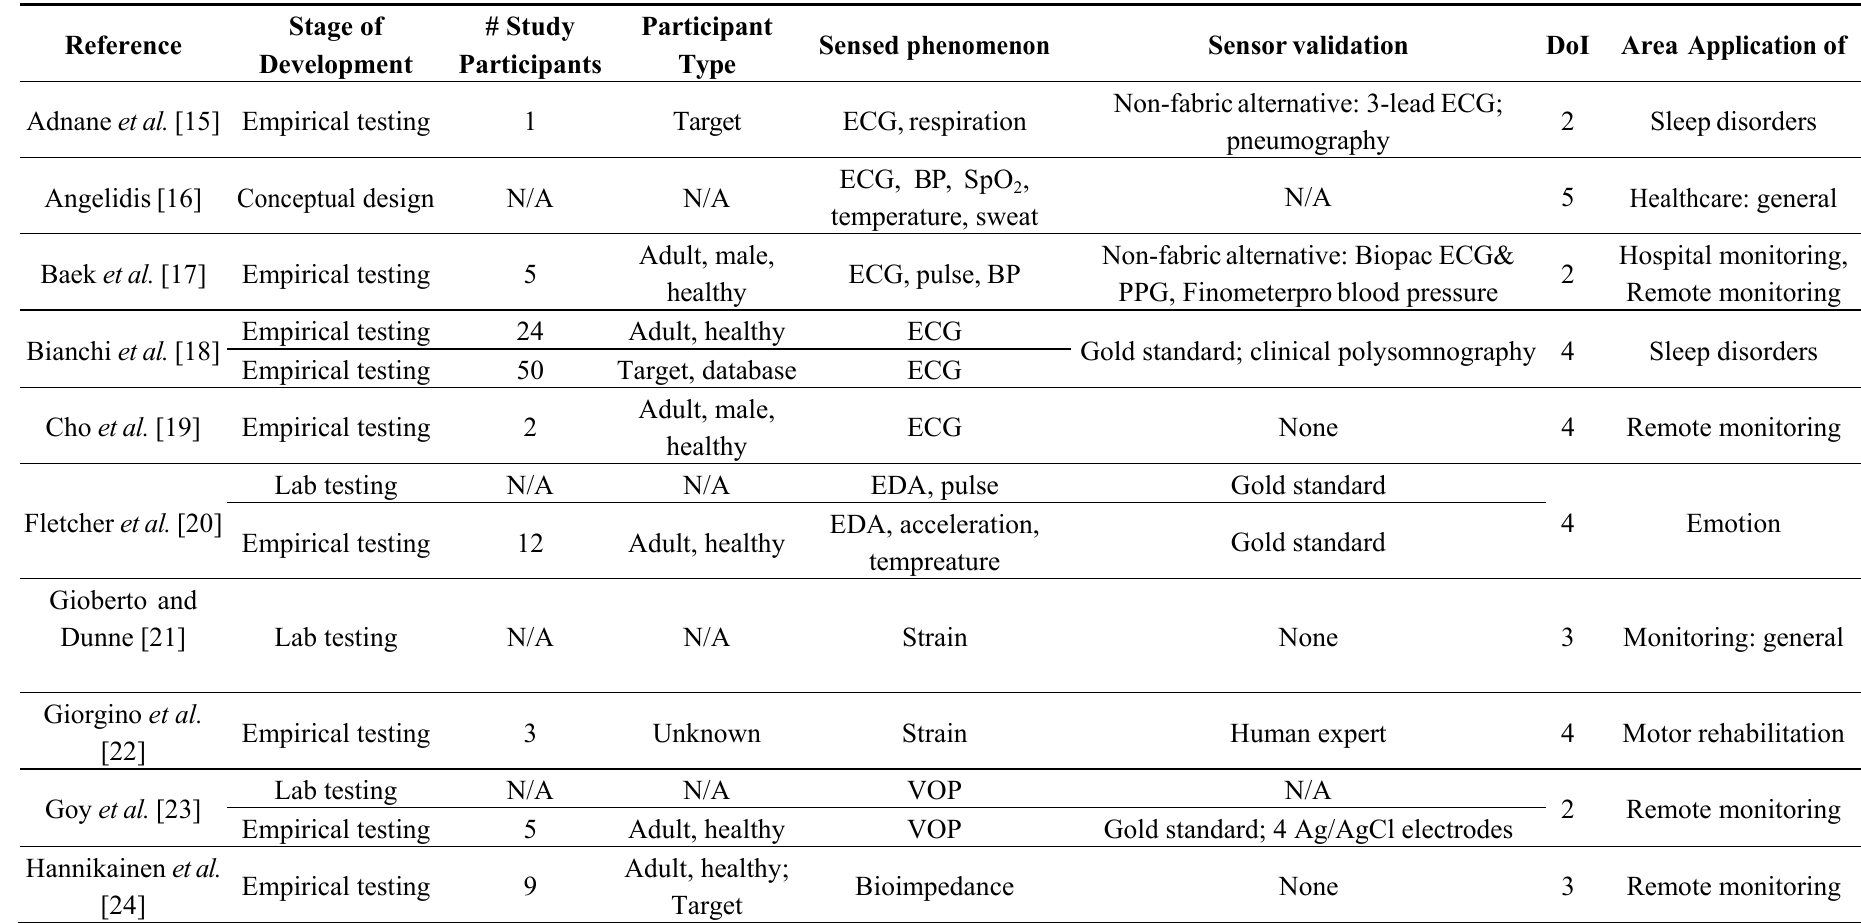
Table 3. Summary of recently published e-textile research (DoI = degree of integration; BP = blood pressure; SpO 2 = saturation of peripheral oxygen; VOP = venous occlusion